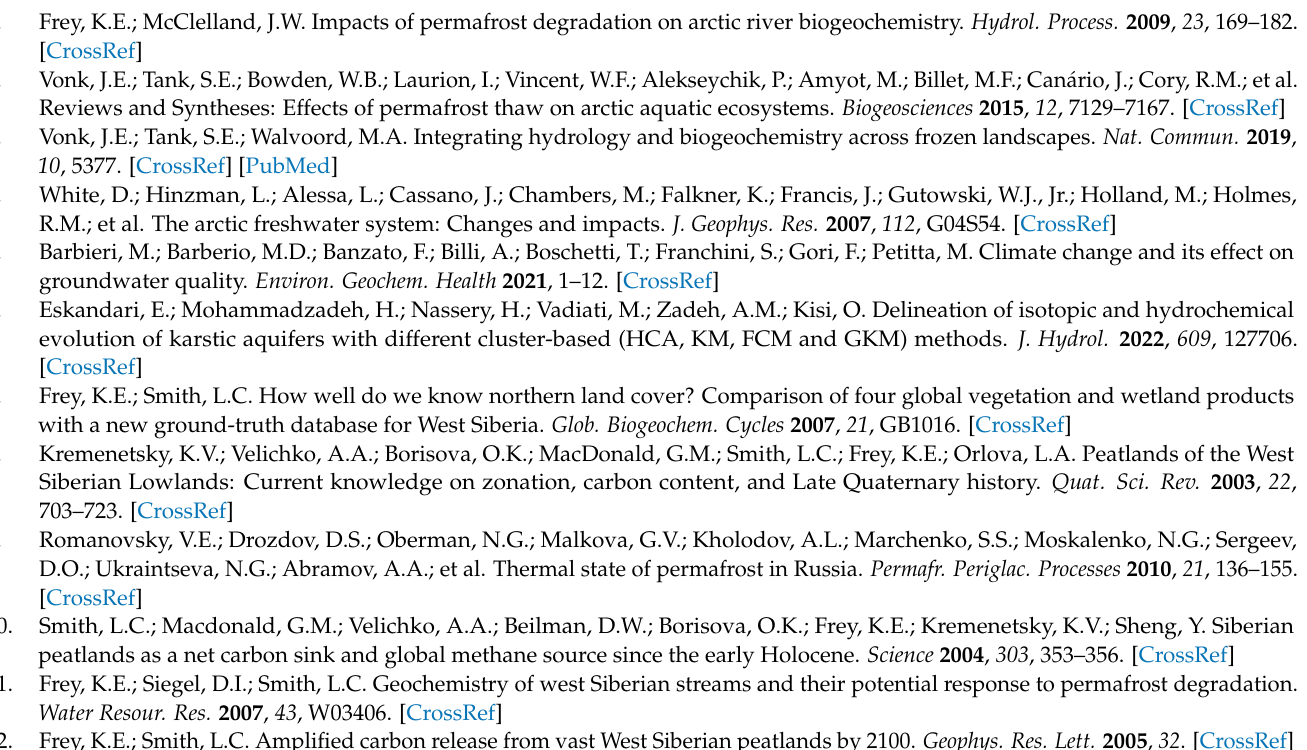
Test comparison concentration tributaries and main channel in different seasons. Table S2. Mean ± SD concentrations of elements and other measured parameters in the Ket River main stem and tributaries. Table S3. Pairwise Pearson correlations of major and trace element concentrations in the Ket River (main stem and tributaries) during summer baseflow and main hydrochemical parameters of the water column and land cover. Significant ( p < 0.05) correlations are given in red and most significant ( p < 0.01) are highlighted in pink. Table S4. Hydrochemical parameters of the Taz River basin (stem and tributaries), July 2019. Table S5. Pearson pairwise correlations of major and trace elements of the river water (Taz and tributaries) with landscape parameters, vegetation coverage and climate. Significant ( p < 0.05) correlations are given in red and most significant ( p < 0.01) are highlighted in pink. Table S6. Results of PCA of ~65 hydrochemical abd 16 land cover variables in ~ 60 sampling points of the main stem and tributaries of the Ket and Taz River basin, collected during summer baseflow. Significant ( p < 0.05) correlations are given in red and most significant ( p < 0.01) are highlighted in